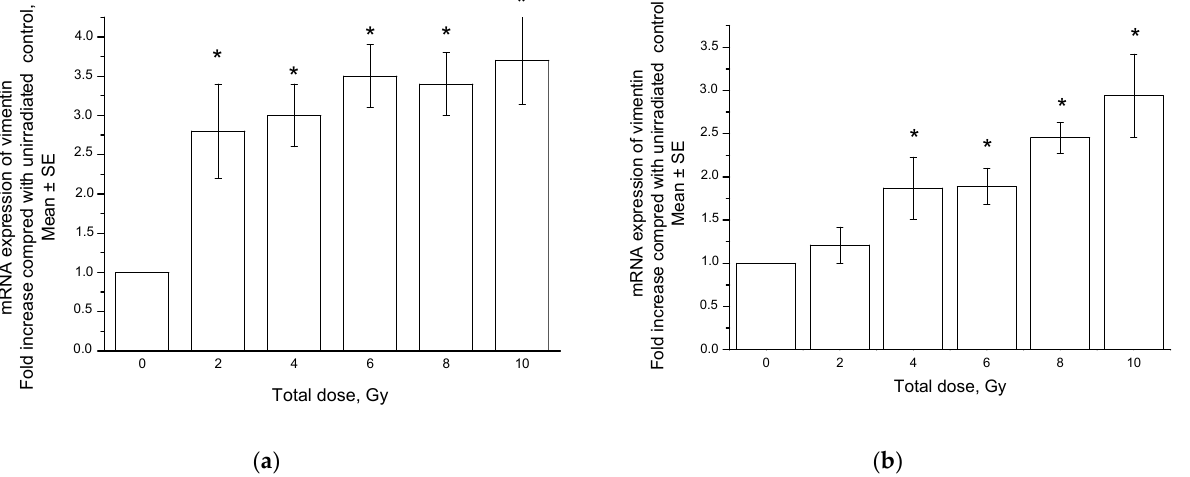
Figure 6. Vimentin mRNA expression in SiHa cells 24 h ( a ) and 8 days ( b ) after fractionated radia- tion exposure. * p < 0.01 in comparison to unexposed cells. The average proportion of vimentin-positive cancer cells was 14.7 ± 2.2% in the group of 35 patients before treatment. This indicator increased significantly to 26.9 ± 2.8% after radiation exposure at a TD of 10 Gy ( p = 0.001). Table 1 shows data on vimentin expression in subgroups of patients with different clinical and morphological parameters of disease